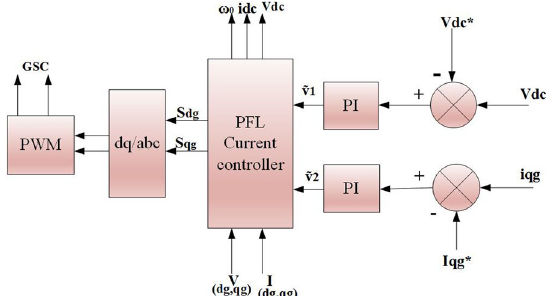
Fig. 10 PFL based current controller